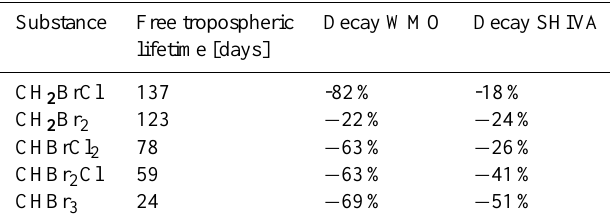
Table 8. Comparison of the decay of the VSLS between boundary layer and upper troposphere (10–13km). The lifetime is given for the free troposphere (Montzka and Reimann et al.,